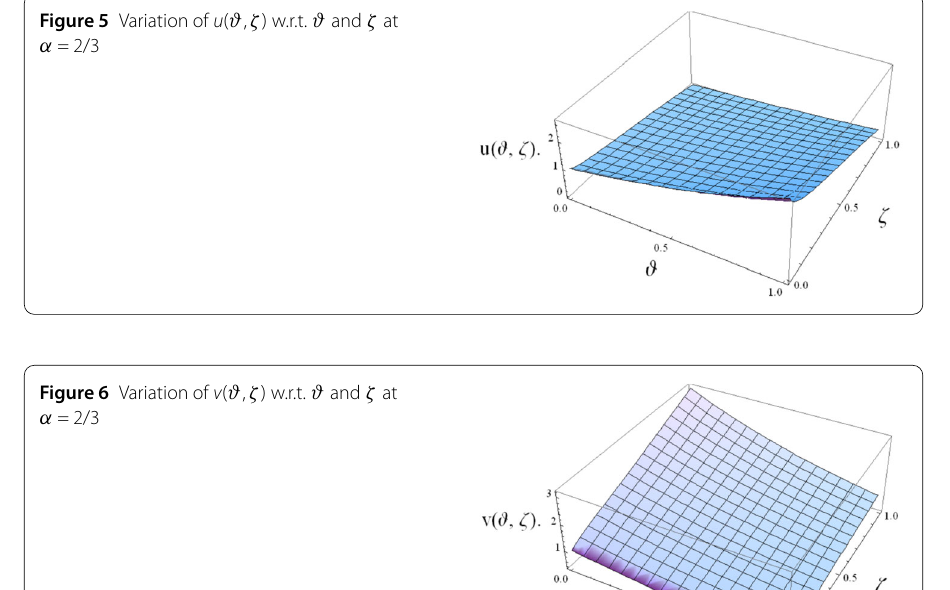
Figure 7 Variation of u ( ϑ , ζ ) w.r.t. ϑ and ζ at α = 1